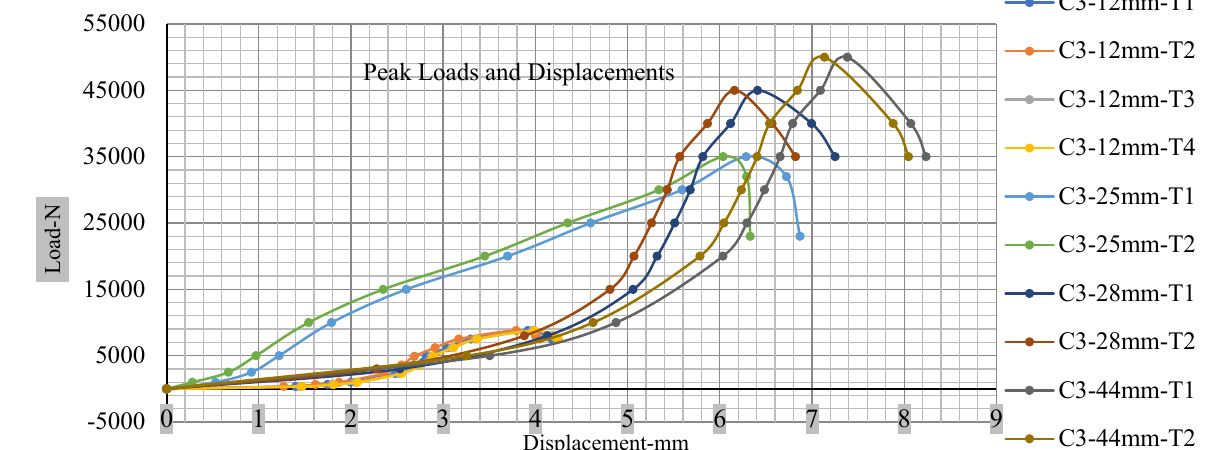
Figure 20. Cell 3 peak loads and displacements.